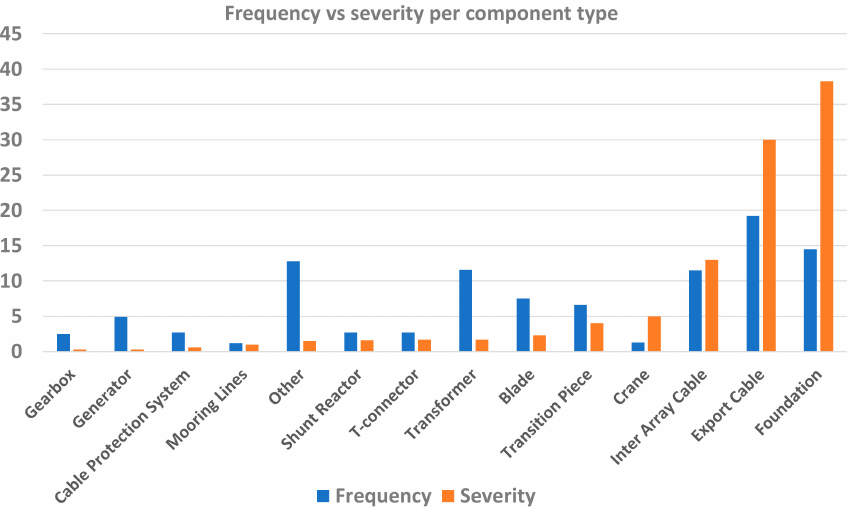
Figure 1. In offshore wind farms, the total claims account for over 50% of subsea cable issues